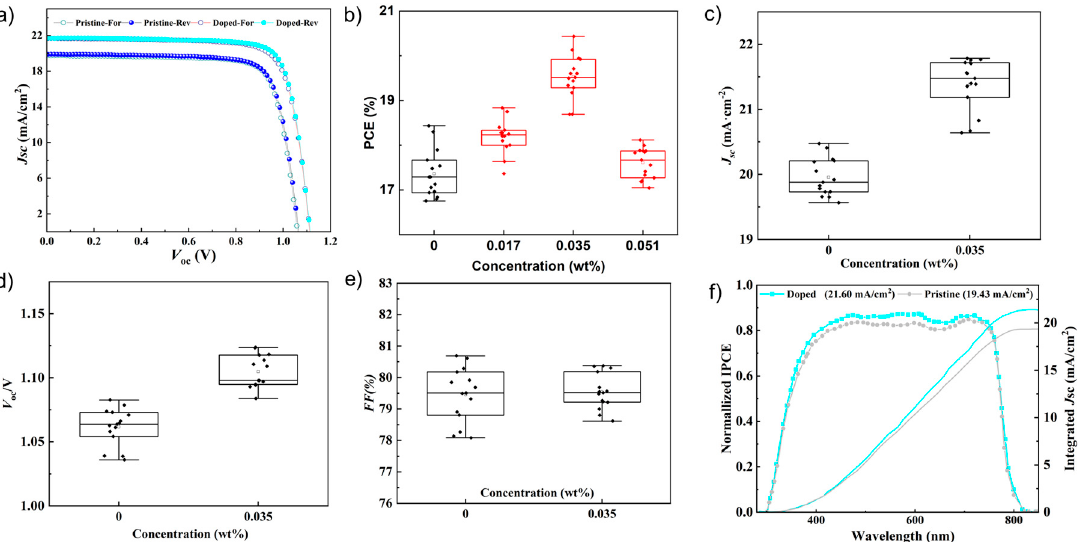
Figure 4. ( a ) J-V curves of the champion PSCs without and with PAT doping (Reverse directions noted as Rev; Forward directions noted as For; the effective area of devices is 0.09 cm 2 ). ( b – e ) Power conversion efficiency (PCE), open-circuit voltage ( V OC ), short-circuit current ( J SC ) and fill factor (FF) of pristine and doped devices. ( f ) External quantum efficiency and integrated J SC .